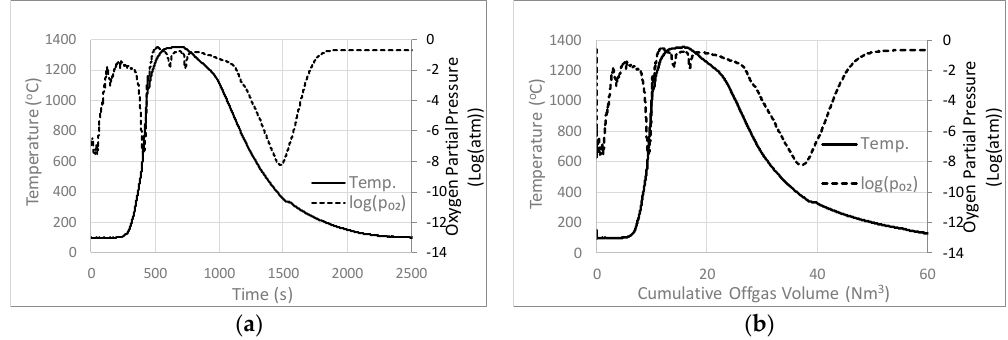
Figure 3. Temperature and p O2 profile measured for the base case sinter pot test (14.7 kPa draft pressure, 36 kg coke /t feed ) as a function of ( a ) time and ( b ) cumulative offgas volume.